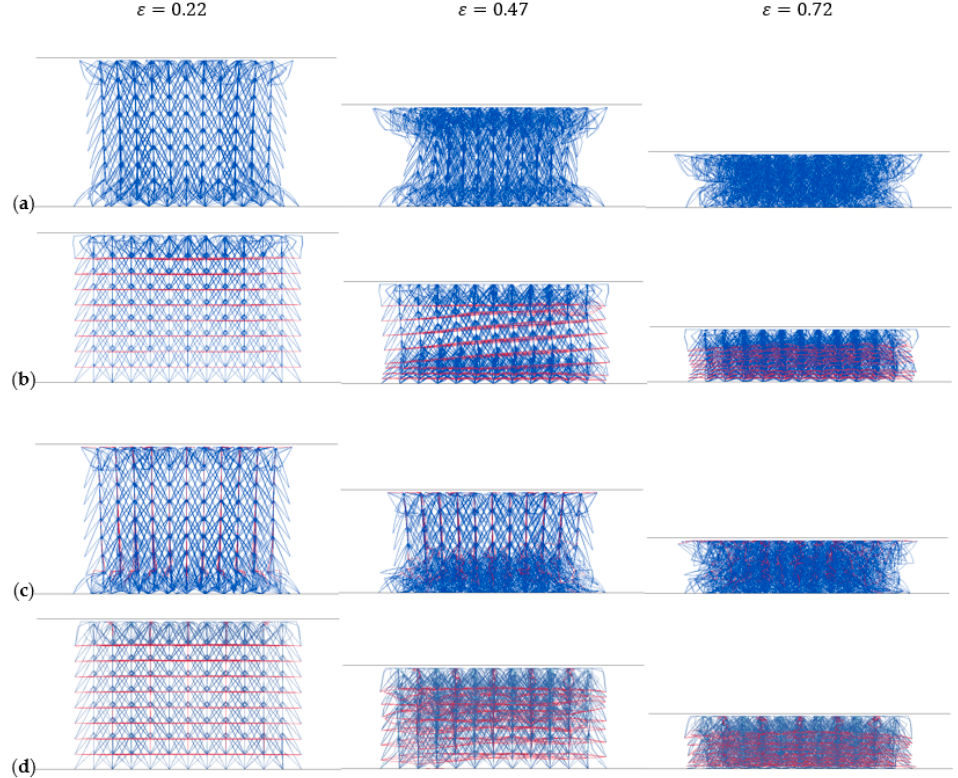
Figure 27. Compressive deformation of four NPR lattice structures: ( a ) Type A NPR lattice; ( b ) Type B NPR lattice; ( c ) Type C NPR lattice; ( d ) Type D NPR lattice.